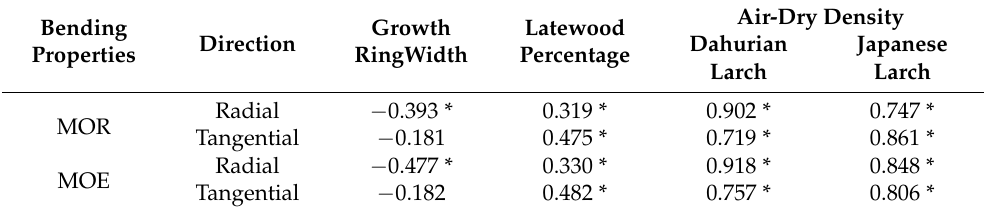
Table 5. Pearson’s correlation coefficient between bending and physical properties.